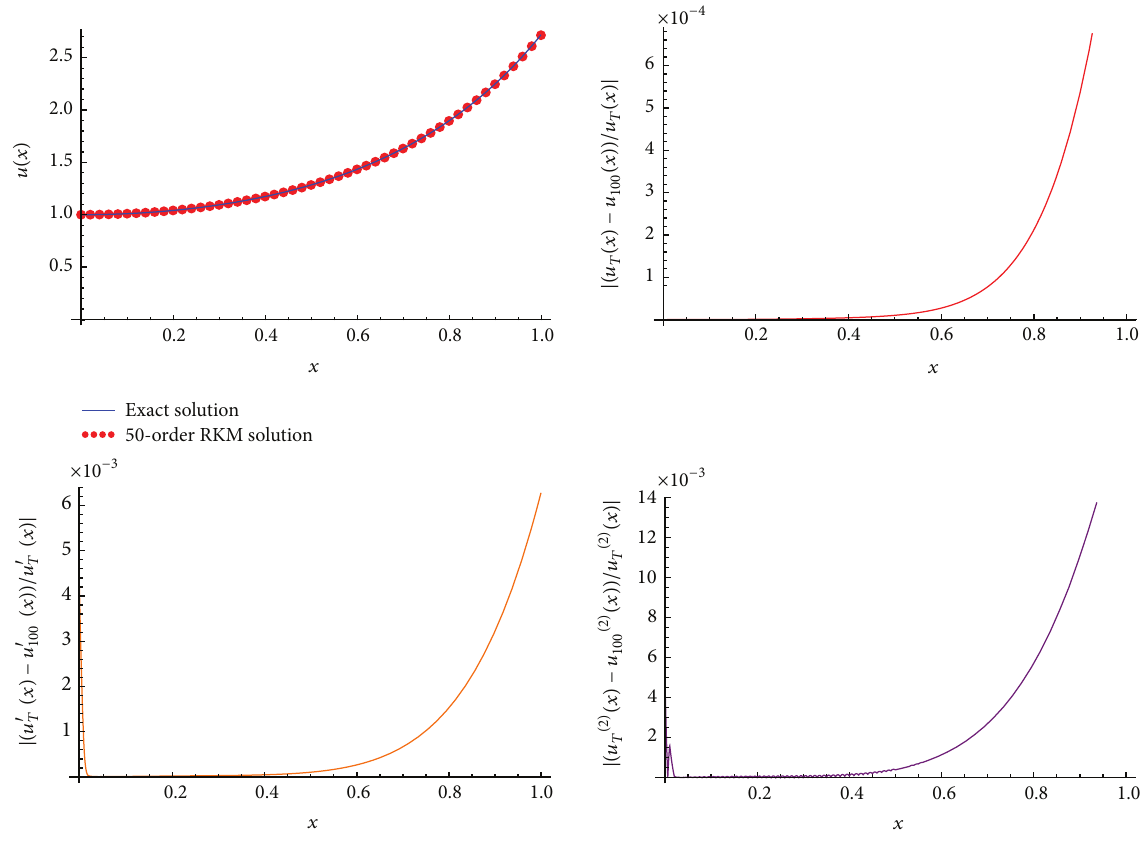
Figure 5: Present numerical method for Example